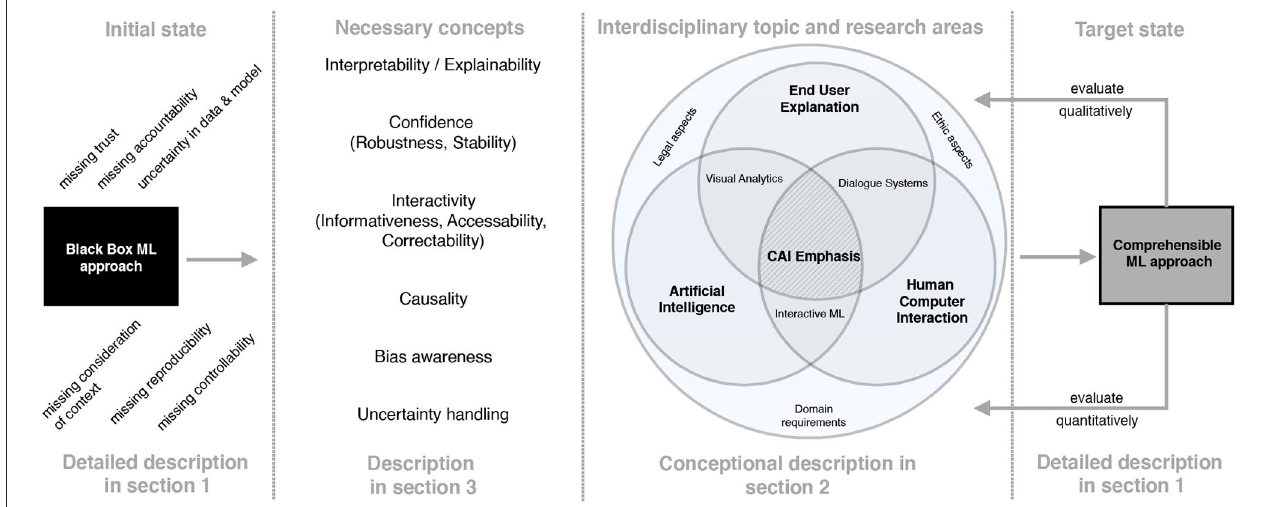
FIGURE 4 | cAI transition framework using interdisciplinary concepts, approaches and measures to reach next level of